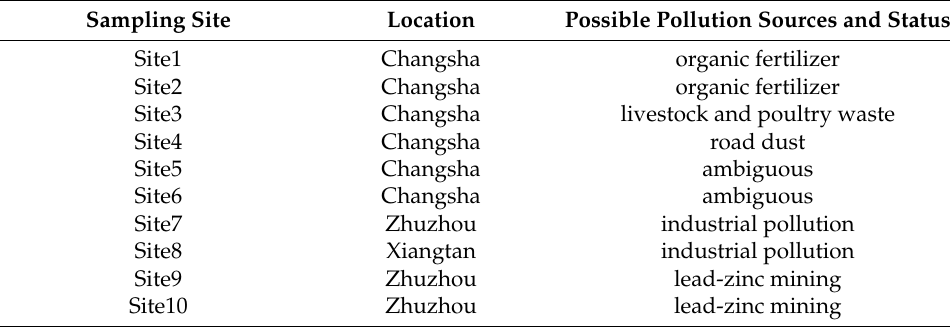
Table 1. Basic information of sampling sites.